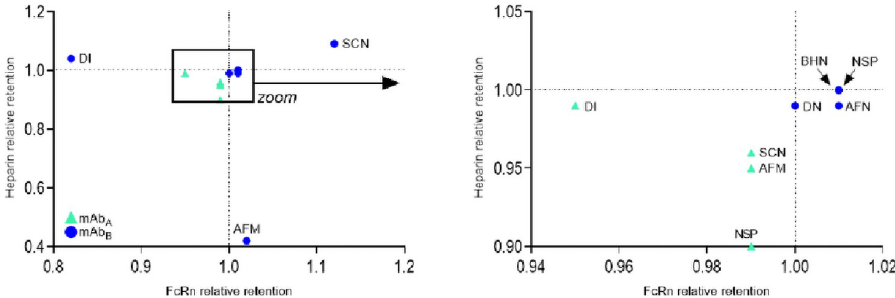
Fig 7. Correlation of FcRn and heparin column retention of labelled antibodies. Green triangle: mAb A series, blue dot: mAb B series. Left: full graphic, right represents the framed area. Dotted lines indicate a relative retention of 1.00. Label Code: NSP: N -succinimidyl propionate; AFM: Alexa Fluor 488-maleimide; SCN: Tm- p -SCN-Bz-DOTA; DI: direct iodination; AFN: Alexa Fluor 488-NHS; BHN: Bolton-Hunter-NHS; DN: DOTA-NHS.